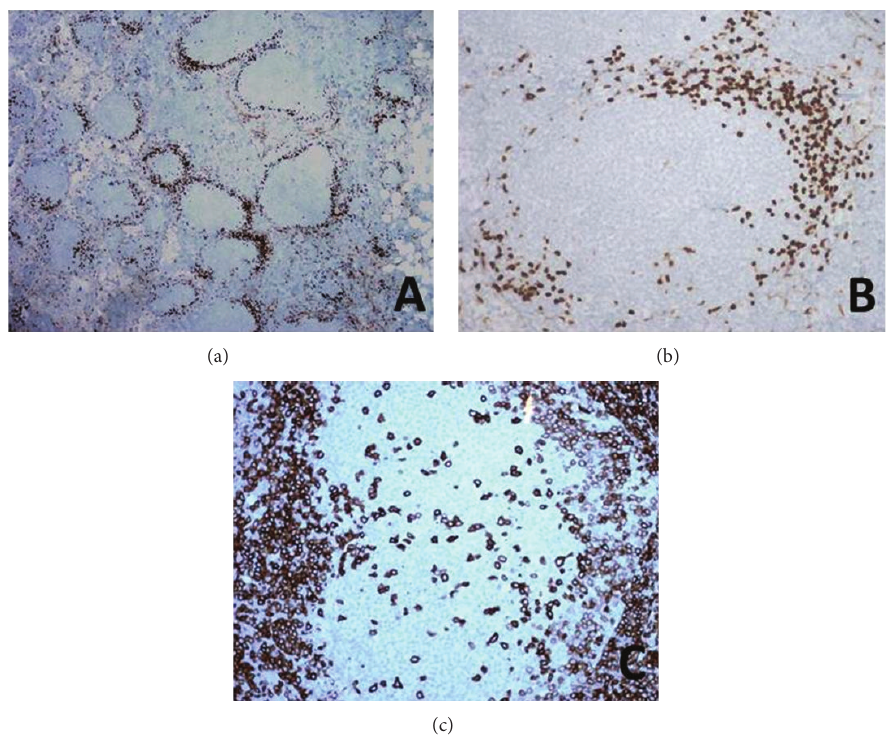
Figure 2: Immunohistochemical staining of in situ mantle cell lymphoma components. Cyclin D1 immunohistochemistry revealed a peripheral rim of positive cells within the mantle zones of the majority of the neoplastic secondary follicles ((a) 4x and (b) 20x). These cells appeared to show dim coexpression of CD5 ((c)